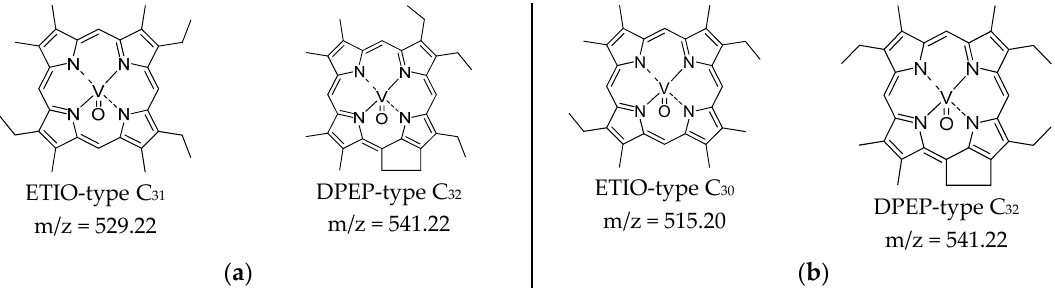
Figure 10. Possible structures of dominant homologs of vanadyl porphyrins of etio and DPEP types in pVP from the resins of HO nos. 1 ( а ) and 2 ( b ).